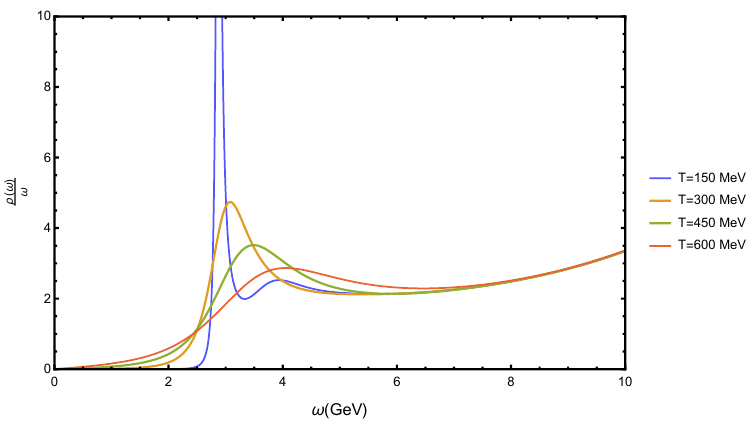
Figure 1 . Spectral function for charmonium at rest for di(cid:11)erent values of temperature.